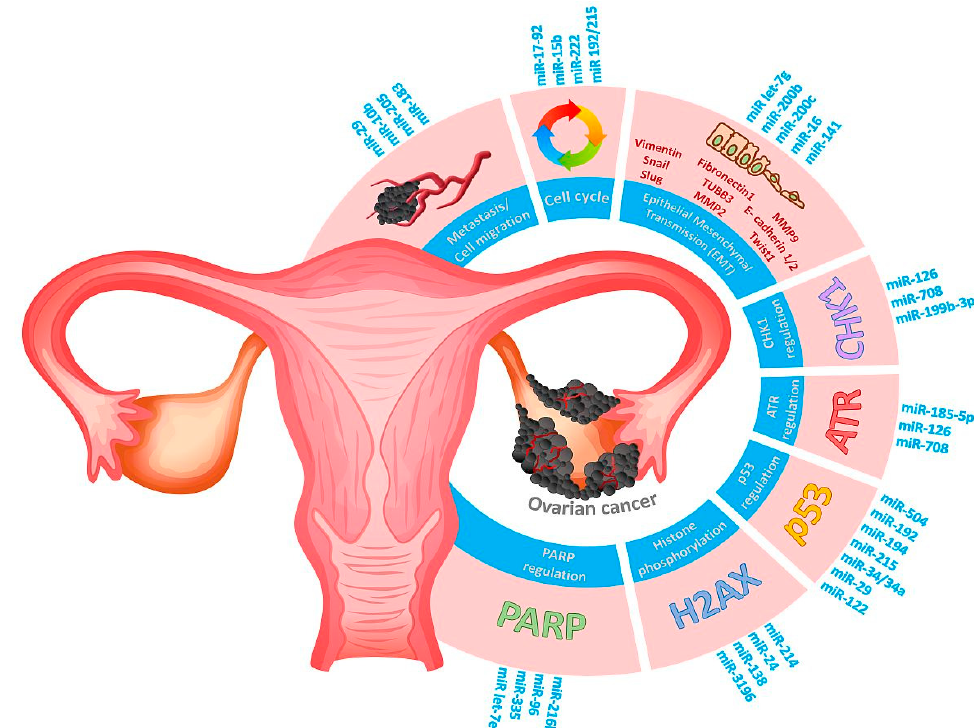
Figure 5. Schematic diagram representing several hallmarks of cancer contributing to pathogenesis of ovarian cancer. RNA markers involved in DDR signaling (PARP1, histone H2AX, P53, ATR, CHK1 regulation), cell cycle disturbance, metastasis, or epithelial–mesenchymal transmission are highlighted in blue.